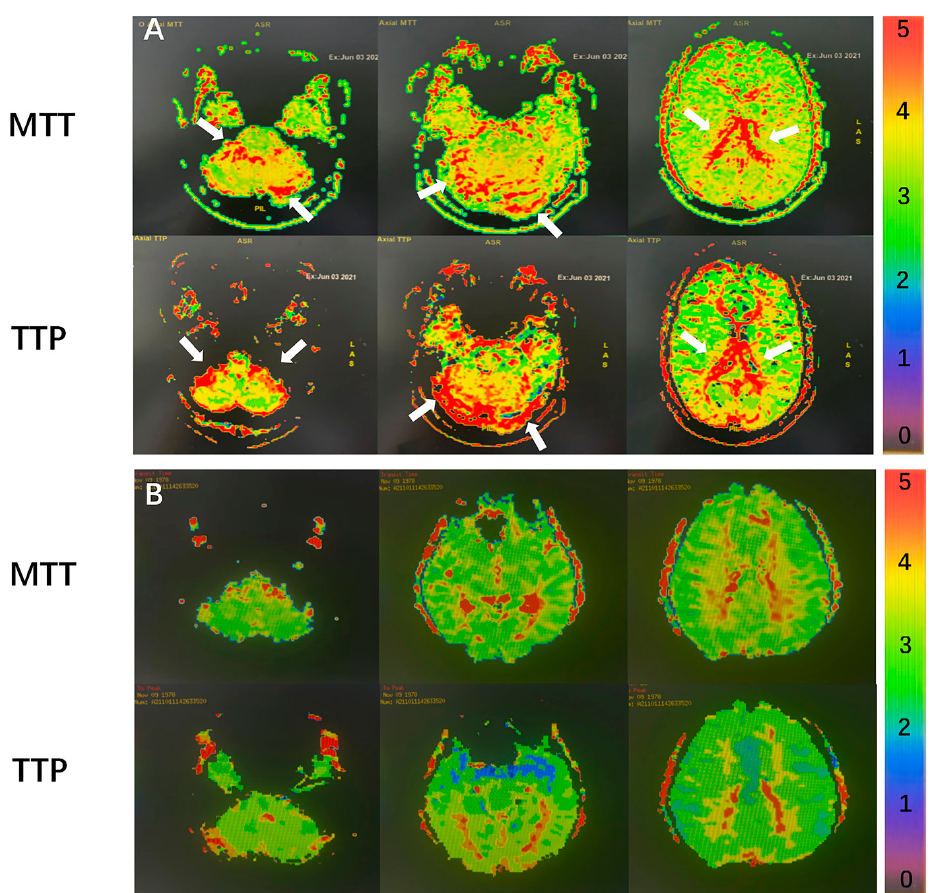
Figure 3. Representatives of PWI findings in patients with cerebral venous outflow stenosis and normal controls. Compared with normal controls ( B ), cerebral perfusion in patients with cerebral venous outflow stenosis ( A ) was significantly decreased. White arrows indicate the areas of hy- poperfusion.